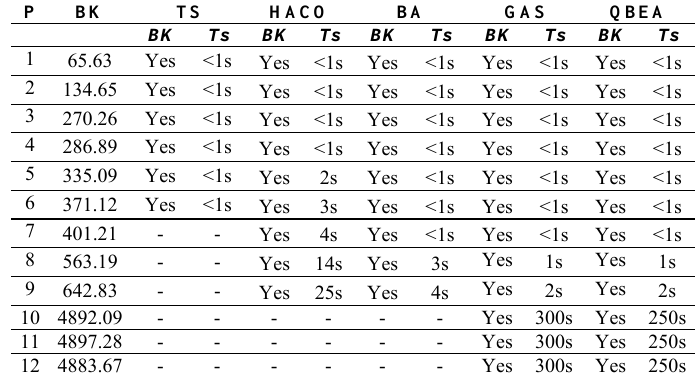
Table 4. Results – TS, SI and Proposed Algorithms.